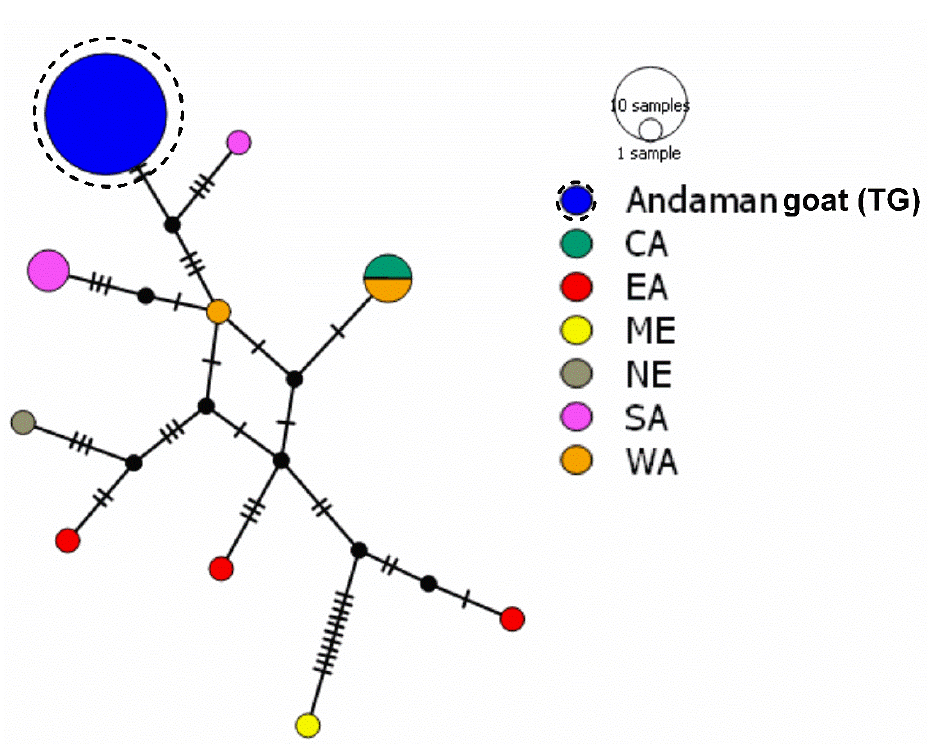
Figure 4. Haplogroup D of Andaman goats and its relationship with D haplogroup goats of different regions. The network was drawn in PopART ver. 1.7 [34]. Analysis was done based on 481 bp hypervariable region (HV1) of mitochondrial D-loop.